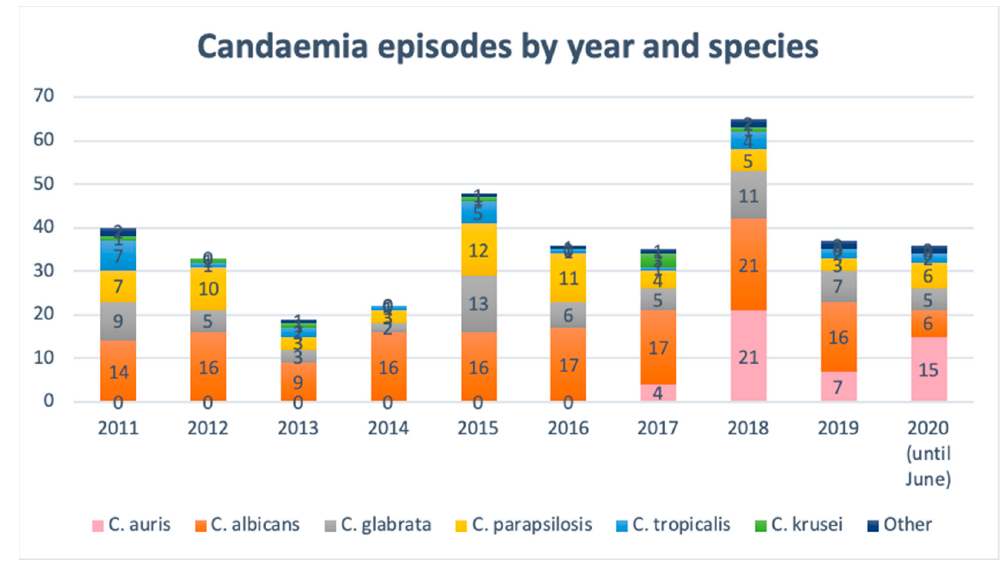
Figure 2. Species distribution in candidaemias produced in our setting since 2011 to June 2020.